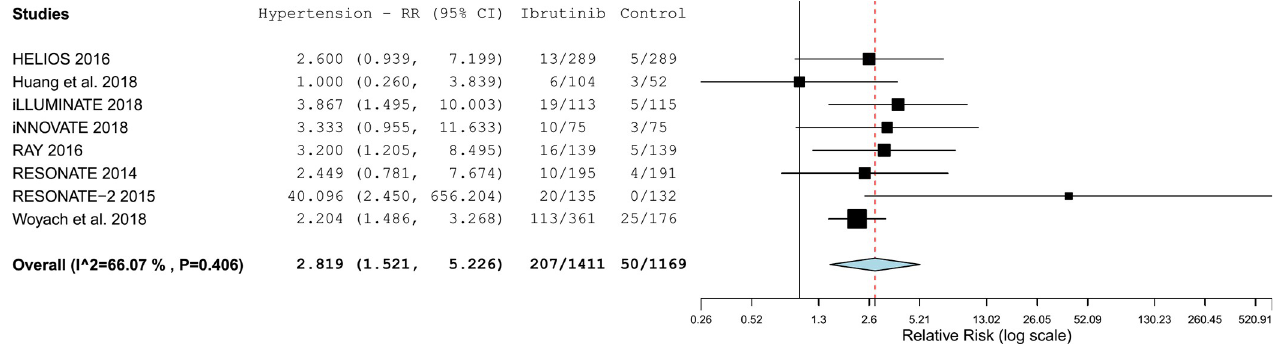
Fig 3. Forest plot with risks of hypertension associated with ibrutinib.